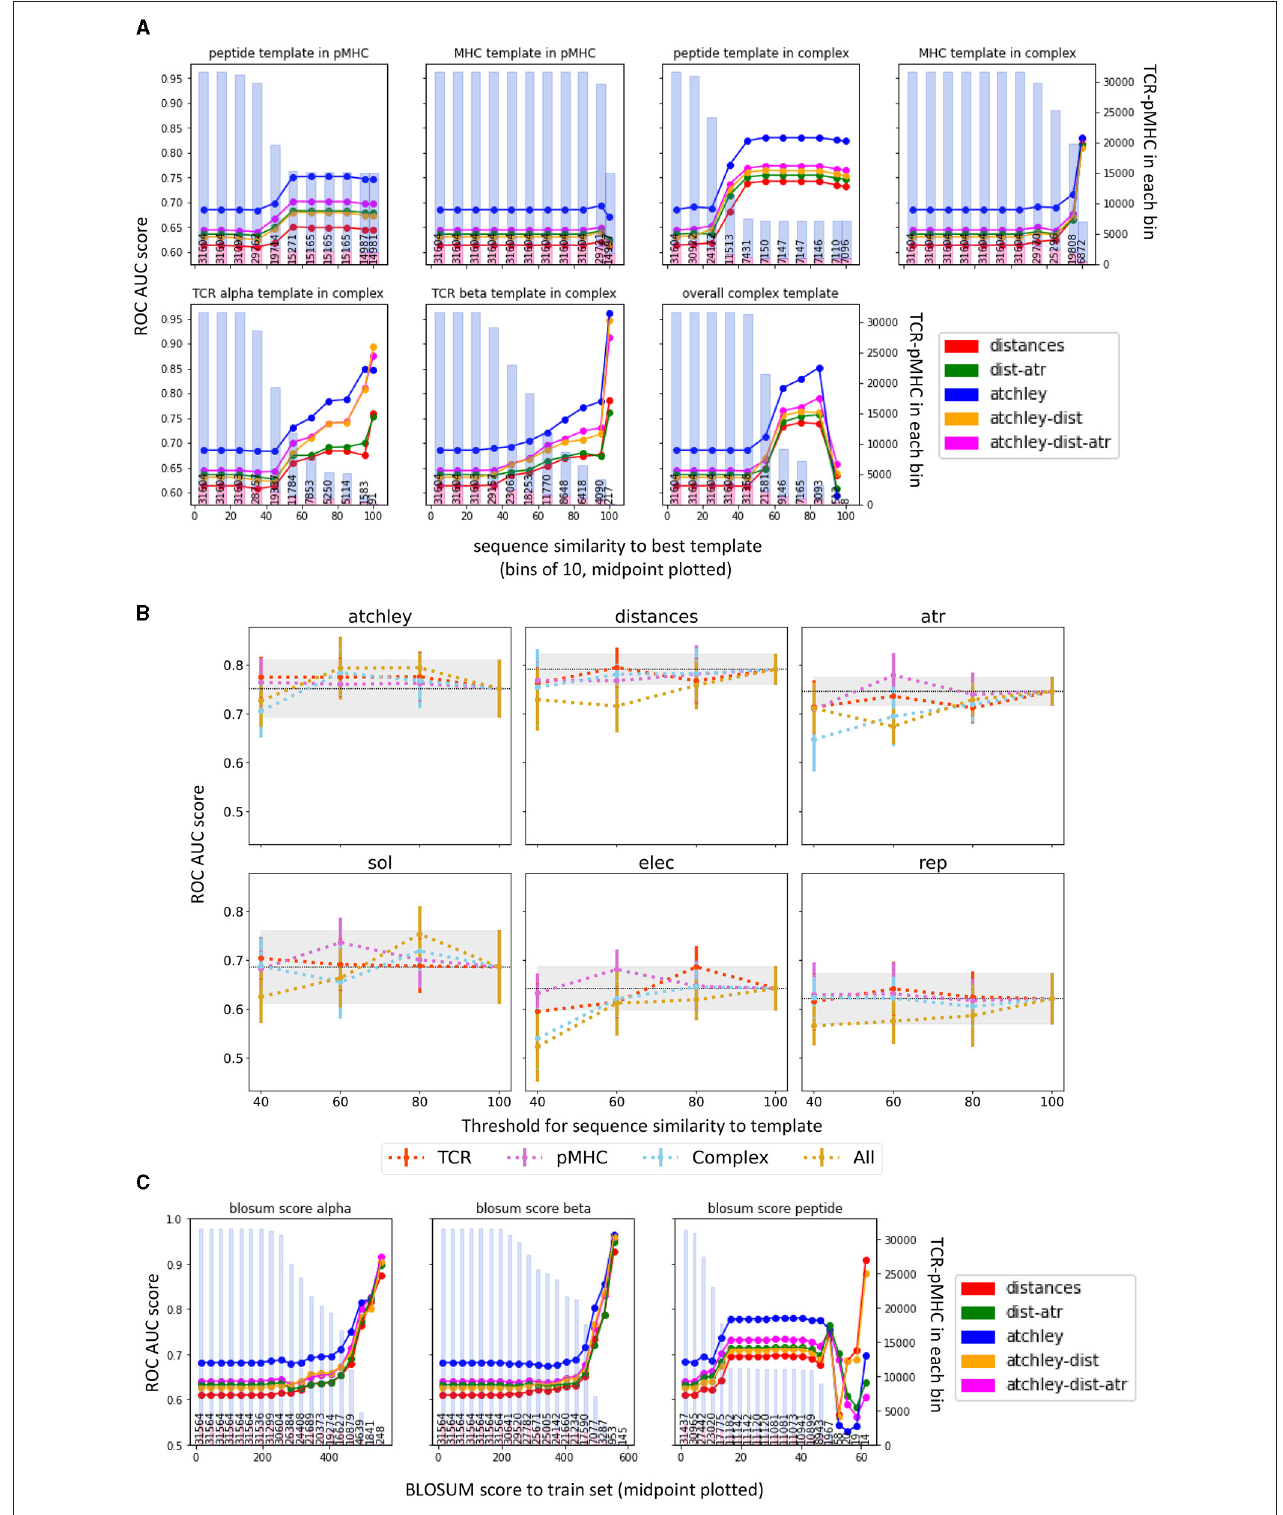
FIGURE 8 | Classifier performance is dependent on sequence homology of the target TCR-pMHC. (A) The performance from all validation sets were combined, and stratified by the similarity between the sequence of the target complex to be classified and the relevant homology modelling template (as outputted